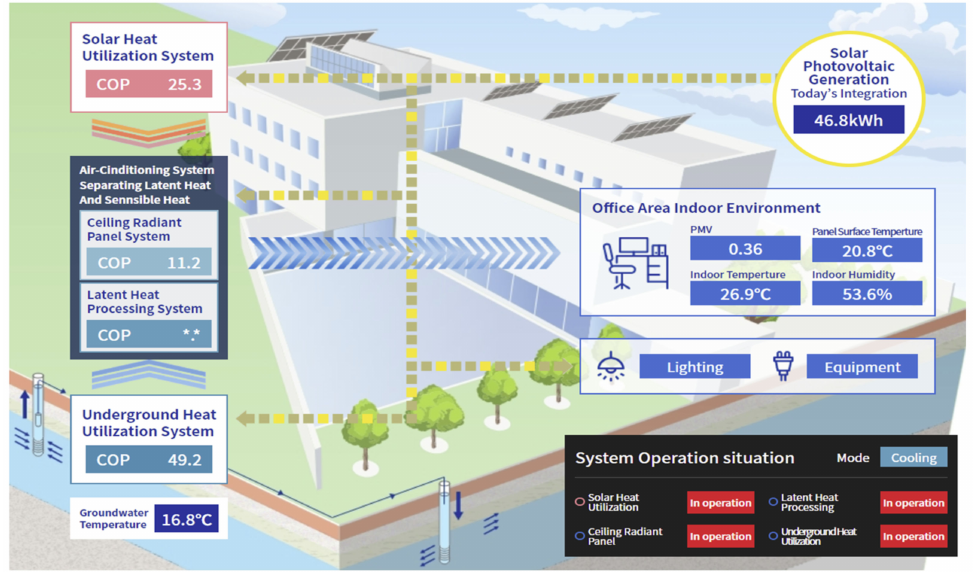
Figure 4. Image of the energy utilization system of the